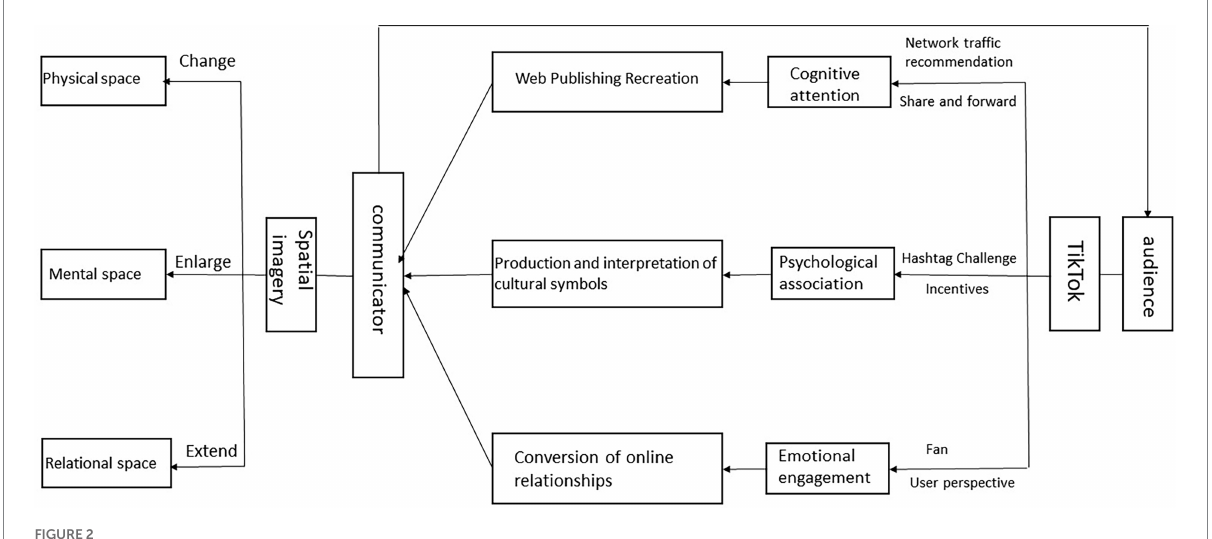
FIGURE 2 Physical, mental, and relational imagery of city on TikTok (PMRT